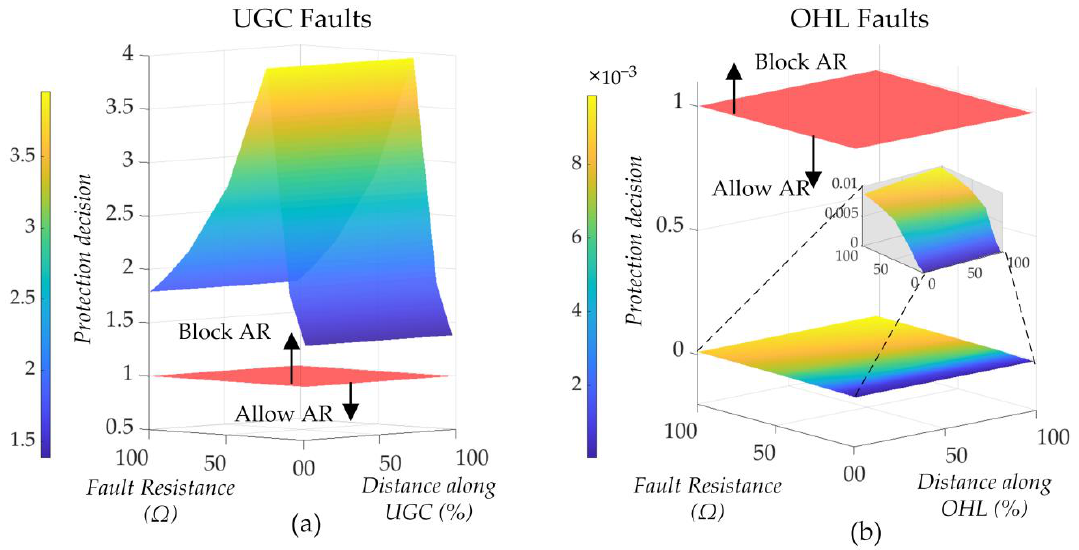
Figure 4. Performance of the proposed scheme for different fault conditions: ( a ) faults on the UGC section, ( b ) faults on the OHL section.